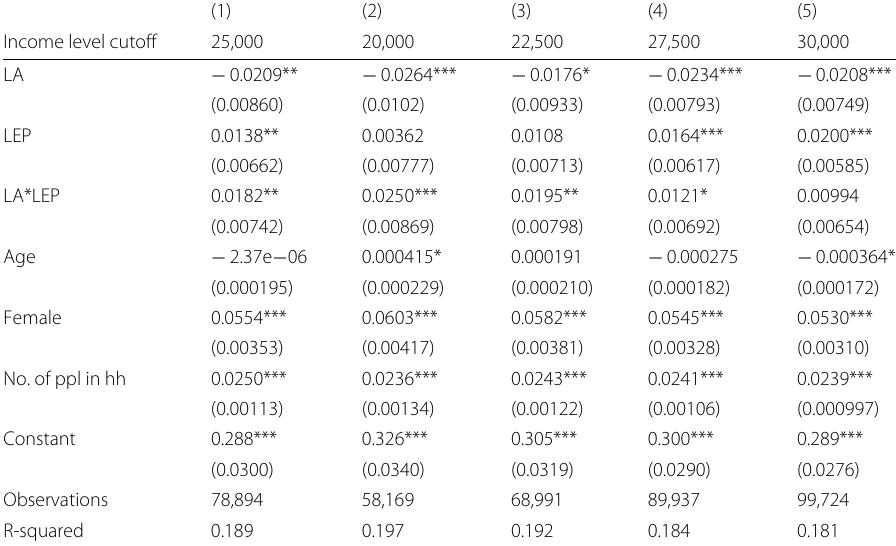
Table 3 Language access and Medicaid take-up rates